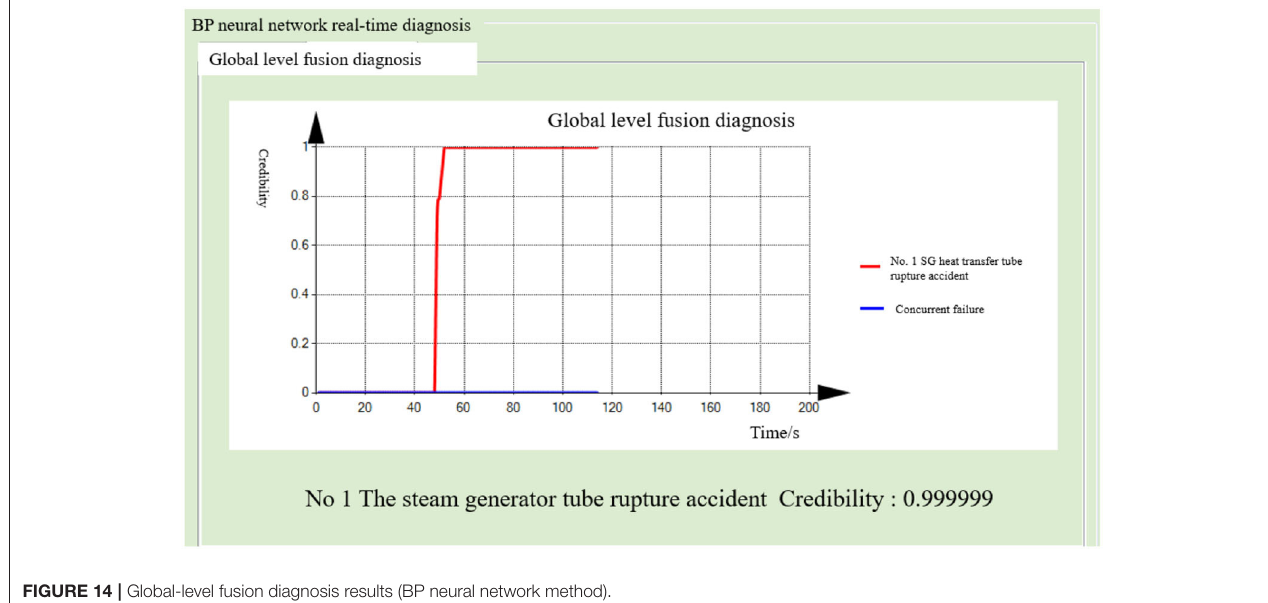
FIGURE 14 | Global-level fusion diagnosis results (BP neural network method).